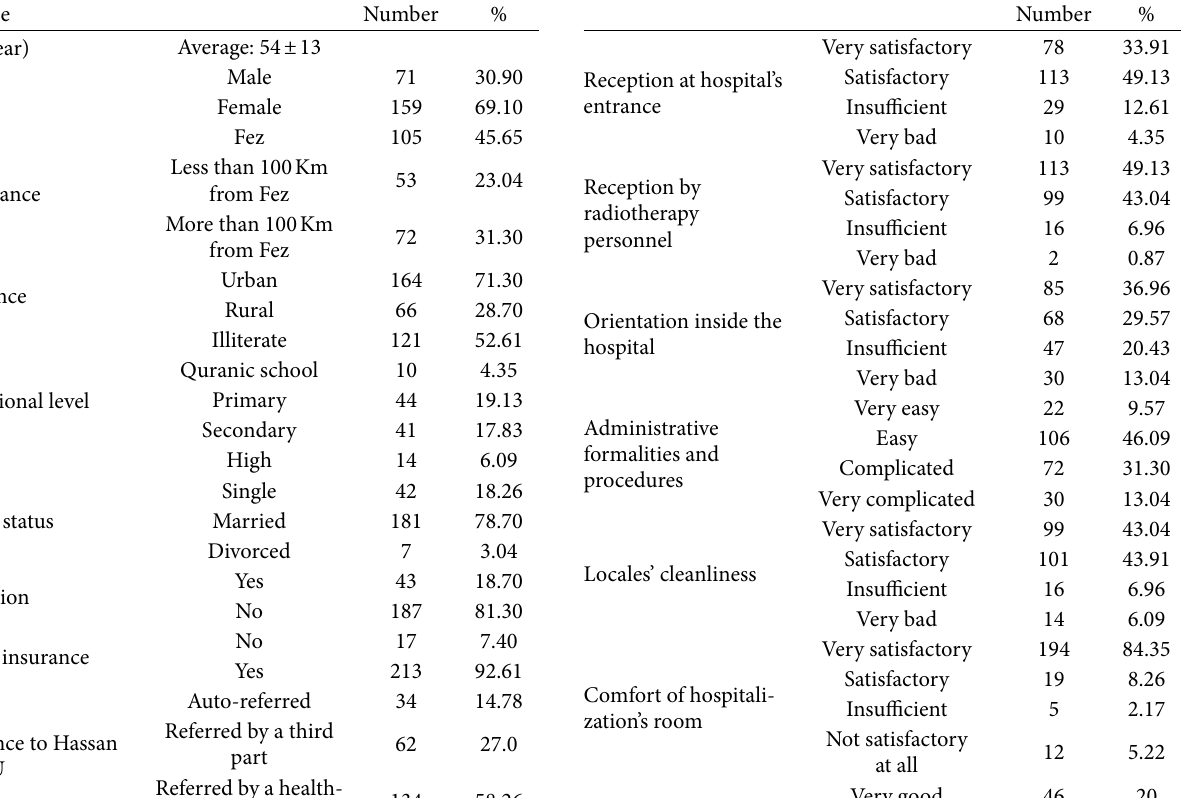
Table 3: Cancer patient satisfaction with reception conditions and comfort (Hassan II CHU, Fez,